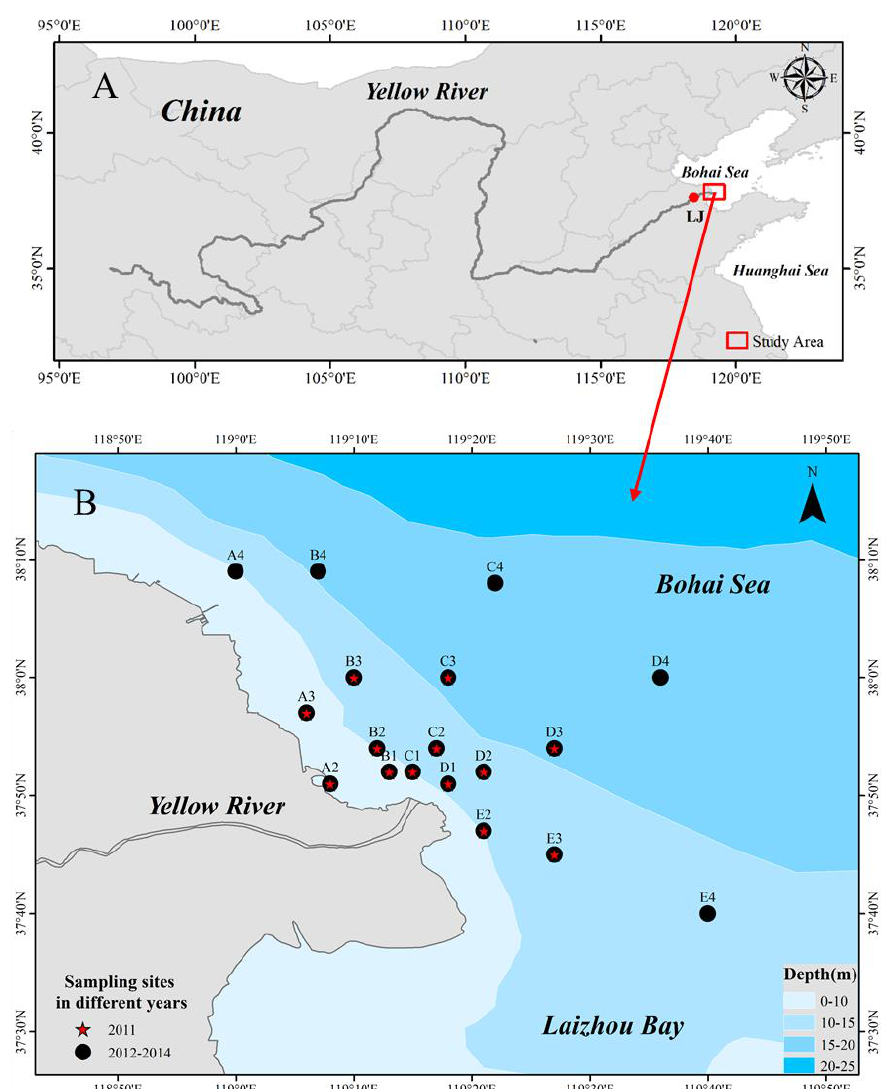
Figure 1. Sampling sites in the Yellow River estuary. ( A ): Location of the Yellow River and the Bohai Sea. ( B ): Study area and sampling sites for the summer surveys from 2011 to 2014. ABCDE in B panel represent the station numbers, and the number behind the station number represents the distance from the sea entrance.